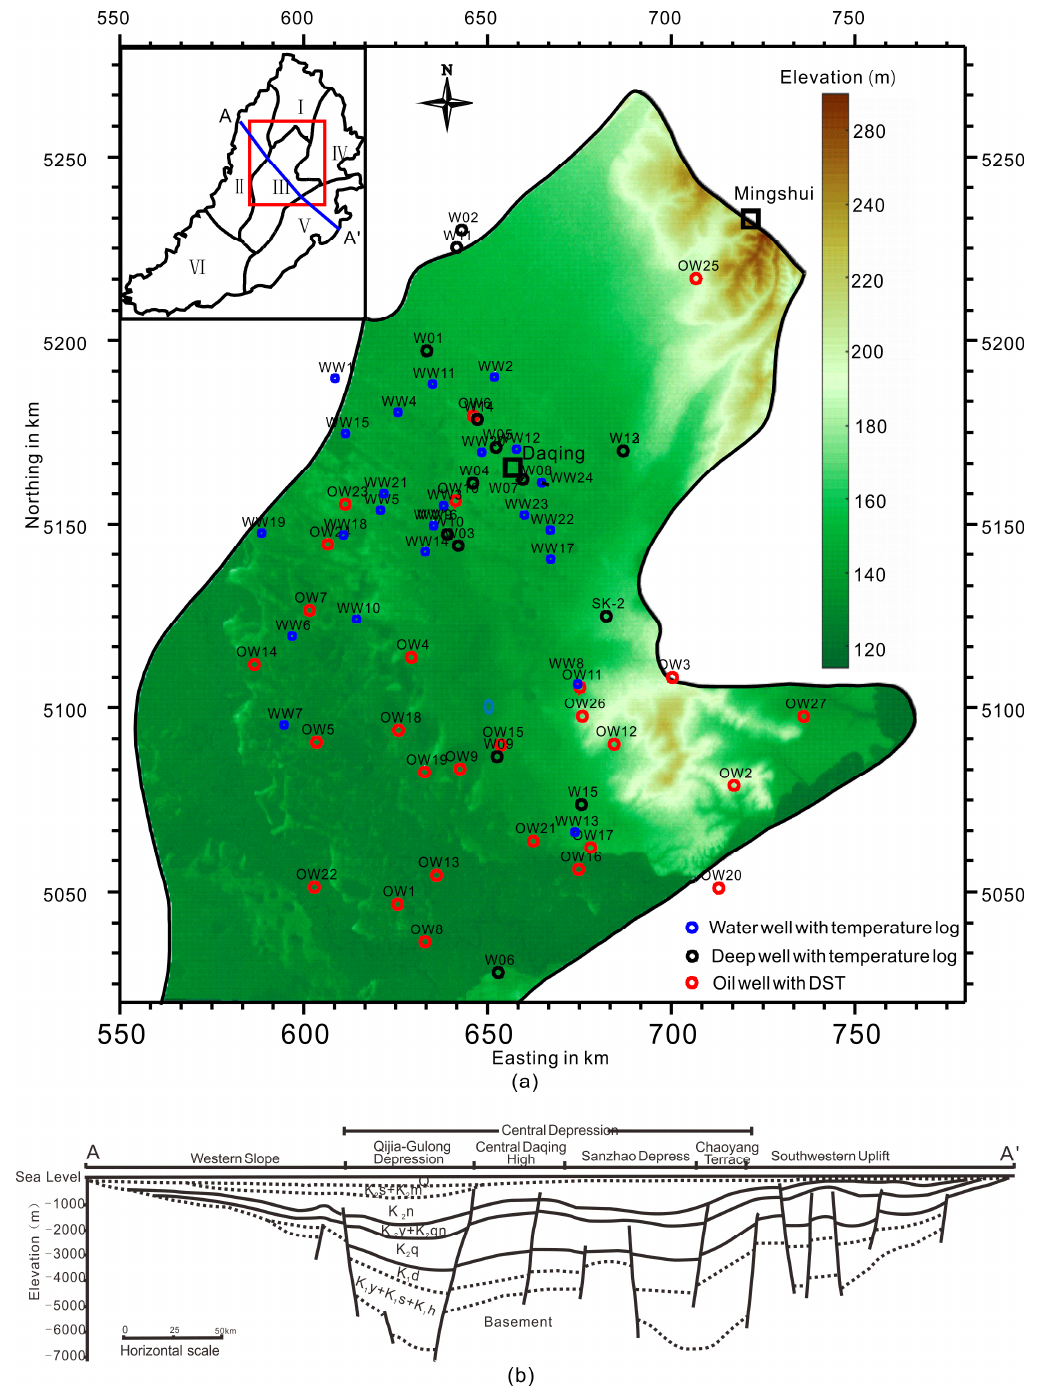
Figure 1. ( a ) The various temperature measurements on the Daqing Oilfield. Major structure zones in the Songliao basin and the structural location of the Daqing Oilfield are also shown; ( b ) stratigraphic cross ‐ section of AA’, its location is shown in ( a ), interpreted with borehole ‐ constrained seismic data. (Reproduced with permission from [22] Ryder et al., 2003 and [23] Wang et al., 2016). Formation symbols: K 1 h is Huoshiling, K 1 s is Shahezi, K 1 y is Yingcheng, K 1 d is Denglouku, K 2 q is Quantou, K 2 qn is Qingshankou, K 2 y is Yaojia, K 2 n is Nenjiang, K 2 s is Sifangtai, K 2 m is Mingshui. Tectonic units: I is North Slope, II is West Slope, III is Central Depression, IV is Southeast Uplift, V is North Uplift, VI is Southwest Uplift.